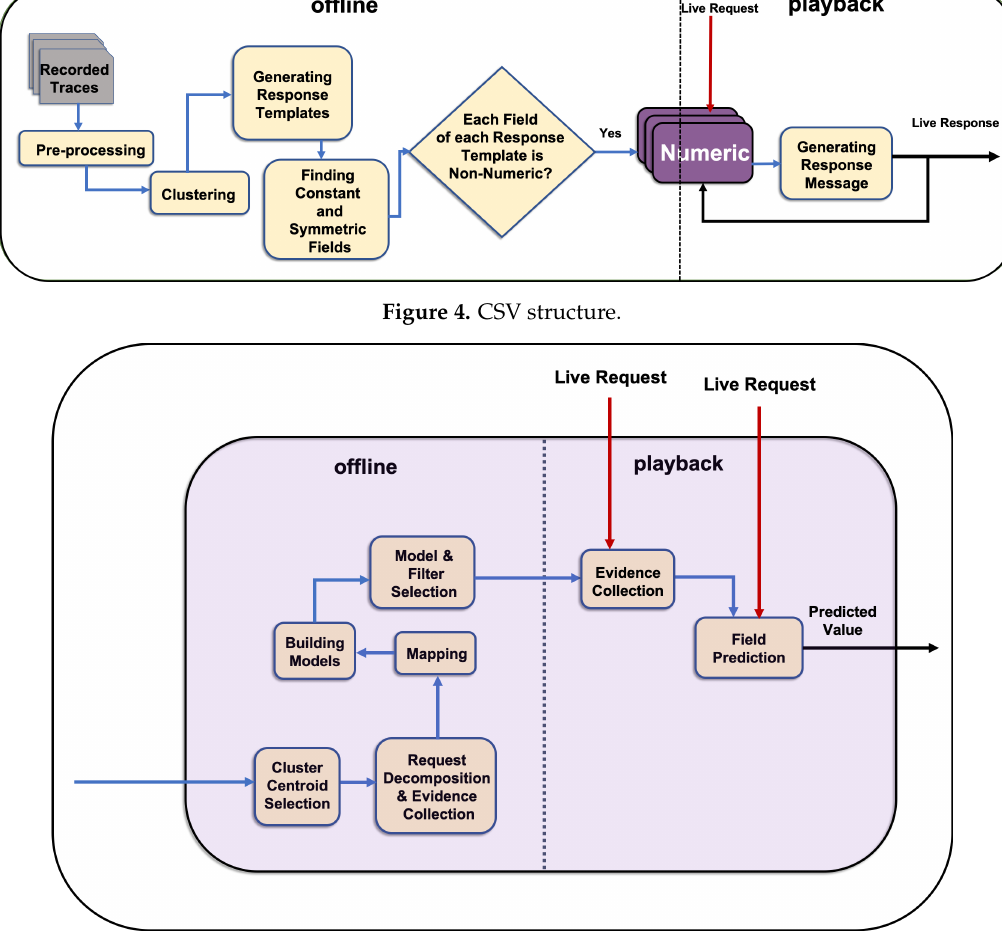
Figure 5. CSV’s numeric module in